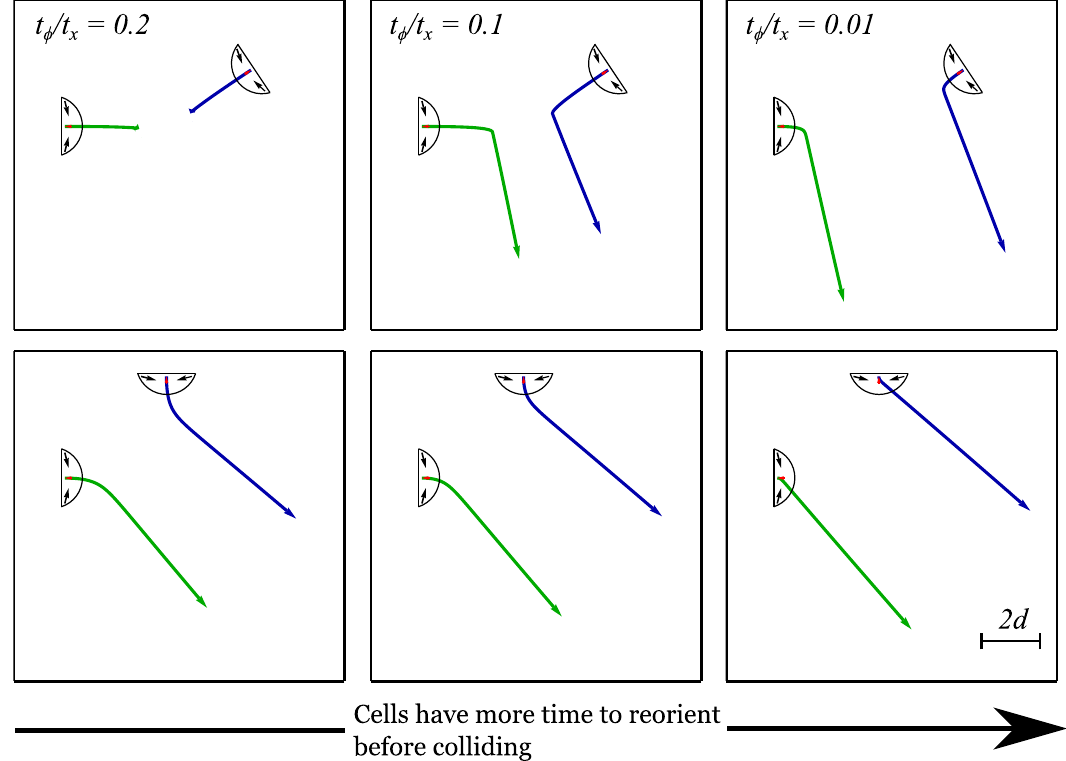
Fig 6. Effect of varying the two timescales that play a role in collision avoidance behavior. t ϕ controls the time is takes for a cell to controls the time it takes for a cell to move forward (see text). Examples of the simulated turn in the presence of a force and t x trajectories of two cells that would collide if they did not interact through the substrate. In all cases, Eq (10) is simulated with ξ 1(2) = d = α = β = E = 1. All units are arbitrary. The two cells have the same velocities which change from V = 0.2 (left) to V = 0.01 (right). The trajectories shown above differ solely due to the ratio of the two timescales, t ϕ / t x , which varies from 0.2 to 0.01. The top and bottom rows have different initial conditions for the position of the second cell (i.e. the cells start approaching one another with a different angle). Note that a collision occurs only in the top left panel. Movies of these simulations and of those obtained with other initial orientations are given in S5, S6 and S7